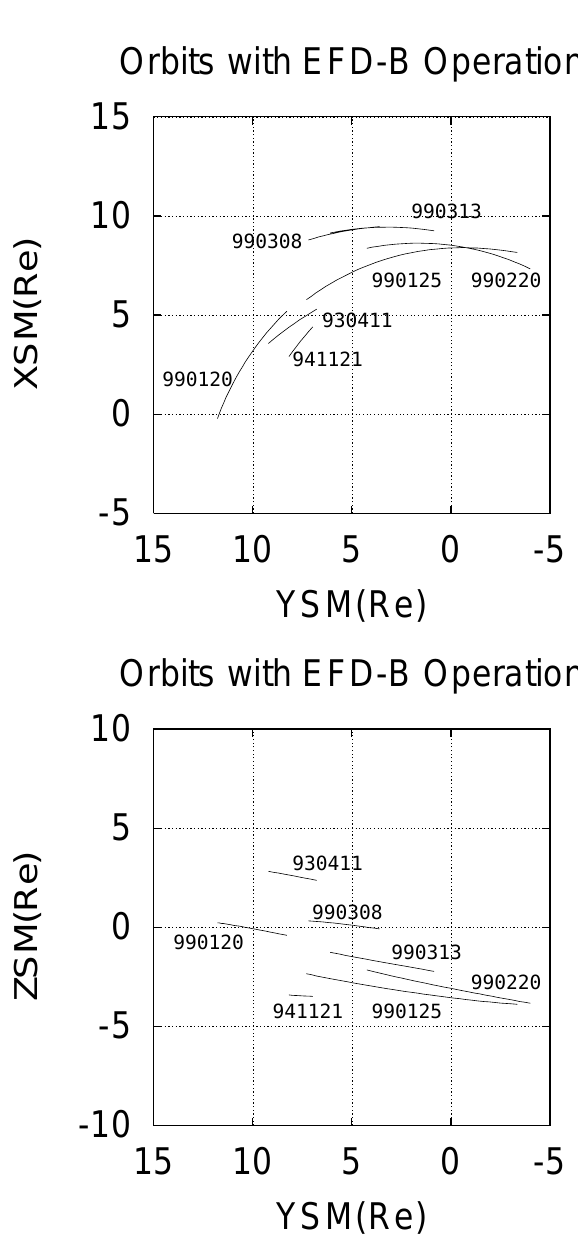
Fig. 4. Seven orbits on which the beam instrument is operated. Locations of the satellite are shown in the SM coordinate system. Dates are noted beside the locations of the orbits.